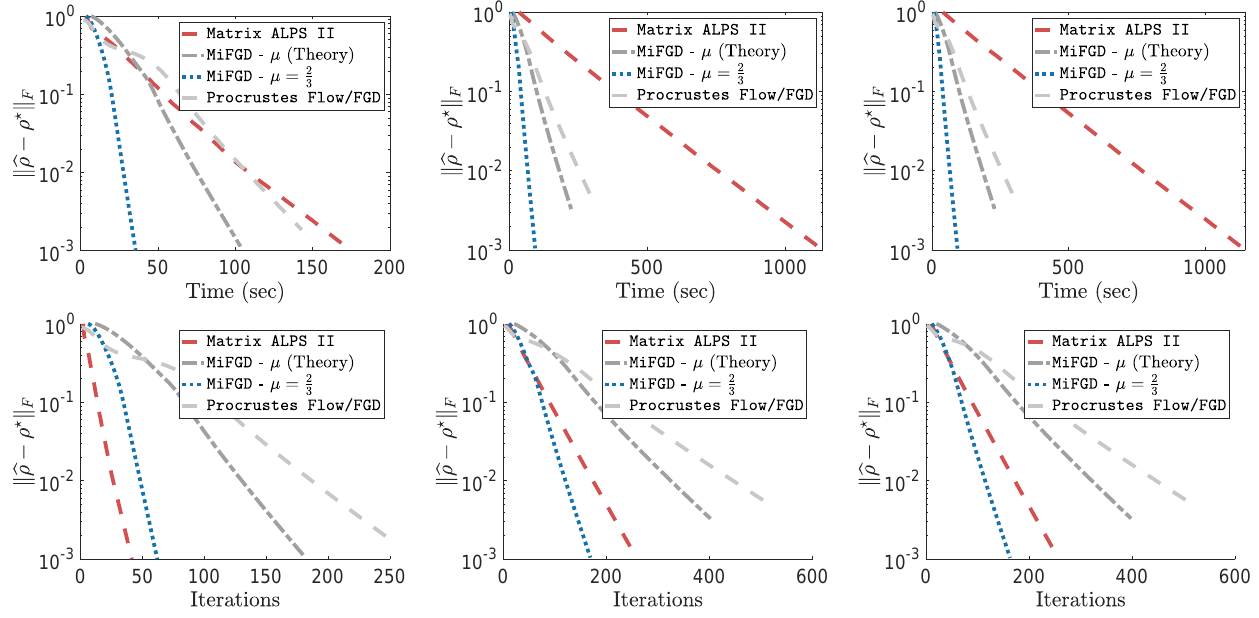
Figure A21. Synthetic example results on low-rank matrix sensing in higher dimensions (equivalent to n = 12 qubits). Top row : Convergence behavior vs. time elapsed. Bottom row : Convergence behavior vs. number of iterations. Left panel : c = 5, noiseless case; Center panel : c = 3, noiseless = w case; Right panel : c = 5, noisy case, (cid:107) (cid:107) 2